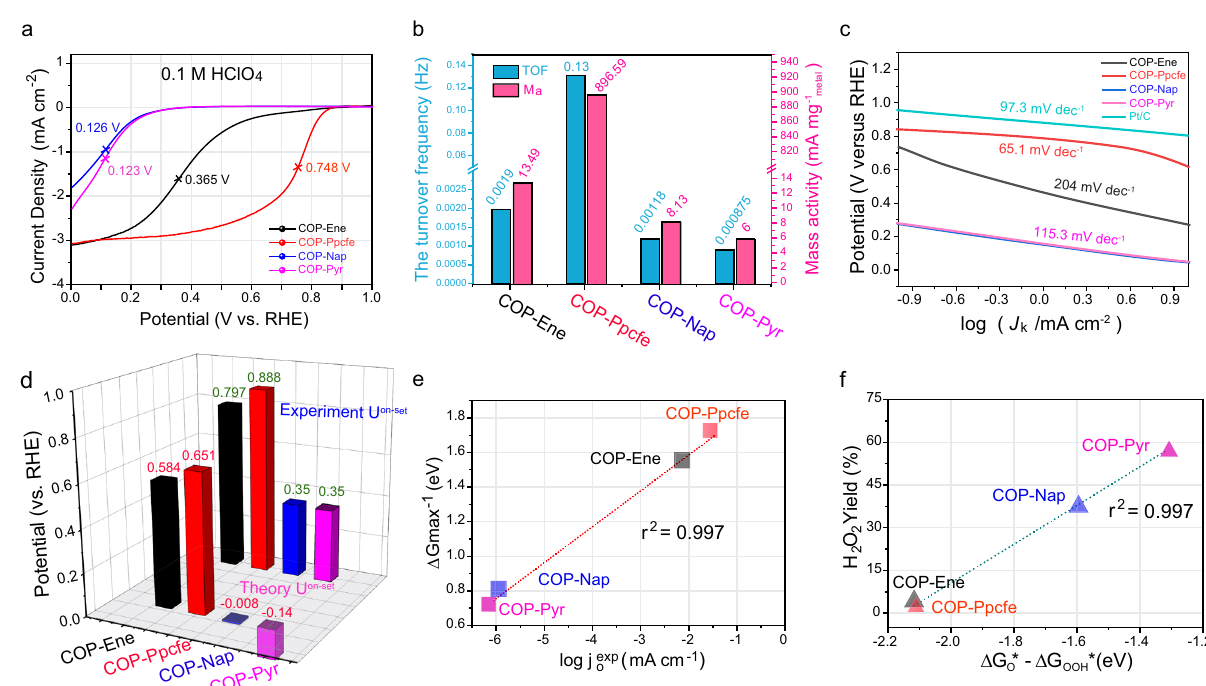
Fig. 3 Electrochemical characterization. a LSV curves of COP-Ene, COP-Ppcfe, COP-Nap, and COP-Pyr samples in O 2 -saturated 0.1 HClO 4 solution at a scan of 5 mV s − 1 and a rotation speed of 1600 rpm. b The turnover frequency (TOF) at 0.7 V vs. RHE and mass activity (Ma) per mass of metal at 0.7 V vs. RHE. c Tafel plots. d Comparison of experimental and theoretical U on-set potential. e Linear relationship of theoretical reaction free energy of DRS ( Δ G max ) vs. the logarithm of exchange current density in the experiment (j 0 exp ). f Linear relationship of experimental yields of H 2 O 2 vs. theoretically thermodynamic propensity for O – O bind preservation ( Δ G O * – Δ G OOH